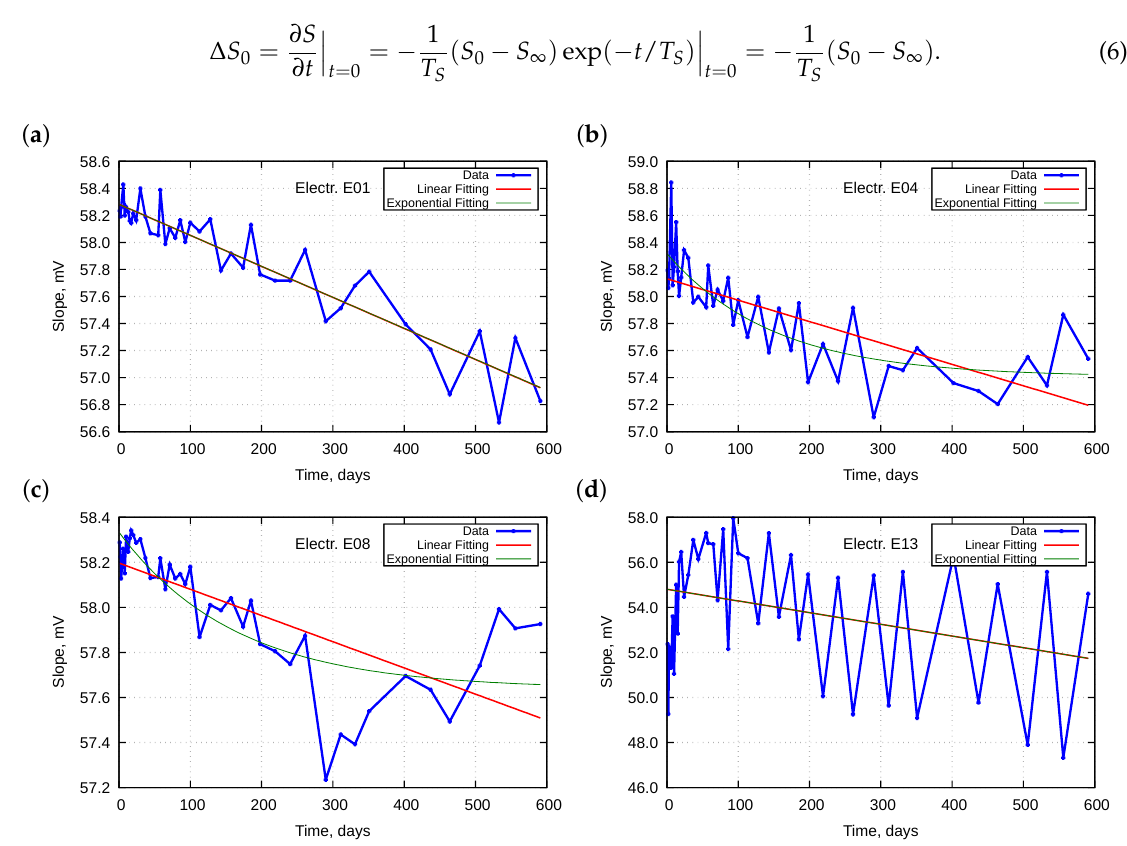
Figure 4. Examples of changes of electrode slopes in time for electrodes: ( a ) E01; ( b ) E04; ( c ) E08; and ( d ) E13. Table 2 collects the obtained approximation